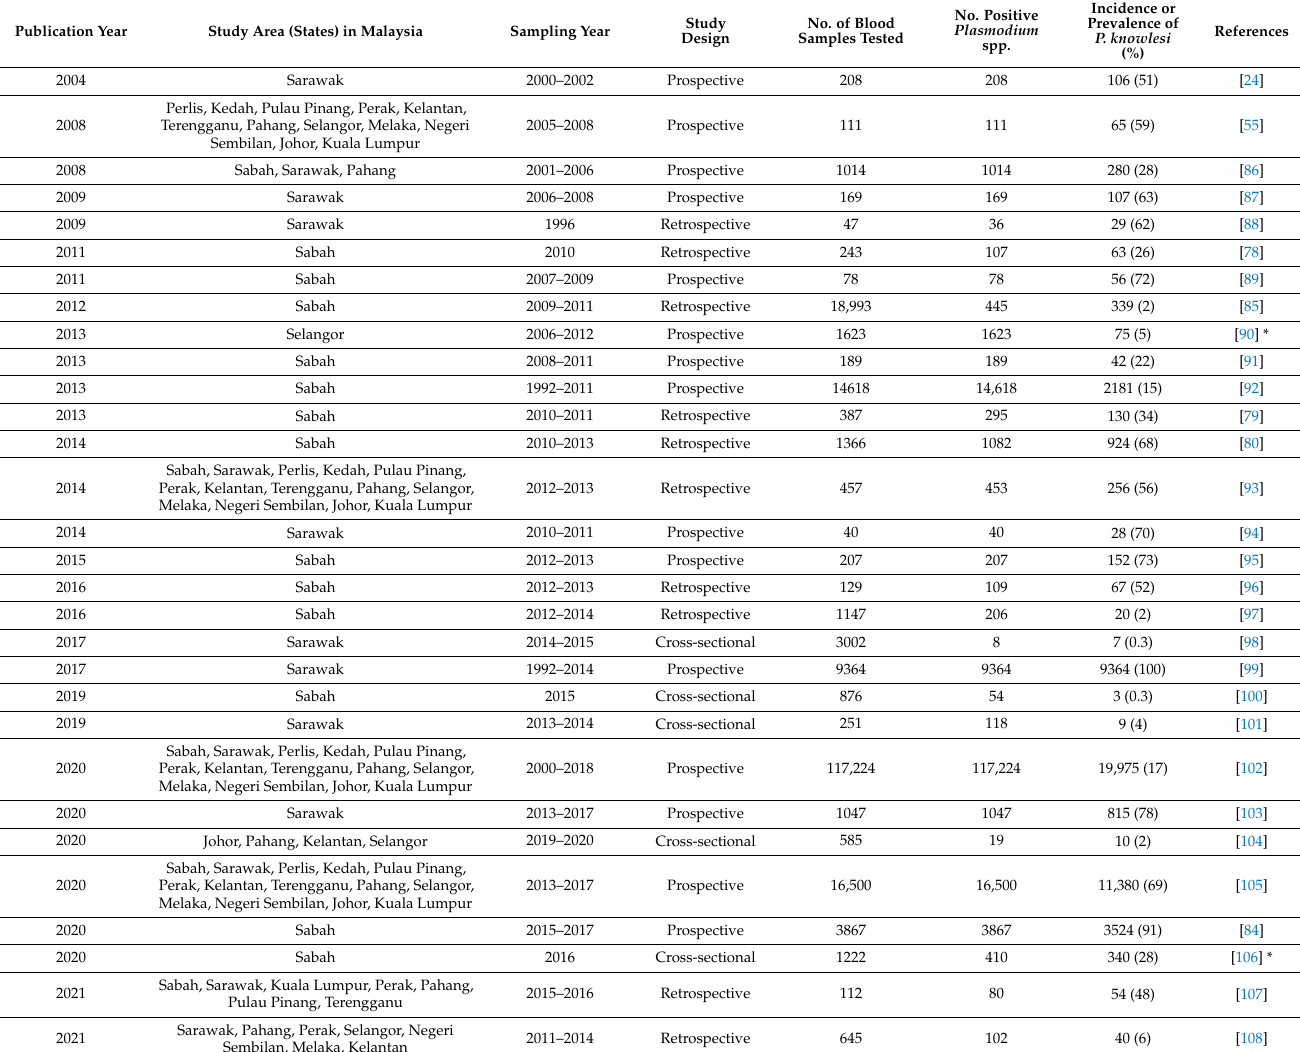
Table 1. Distribution of P. knowlesi parasite reported in